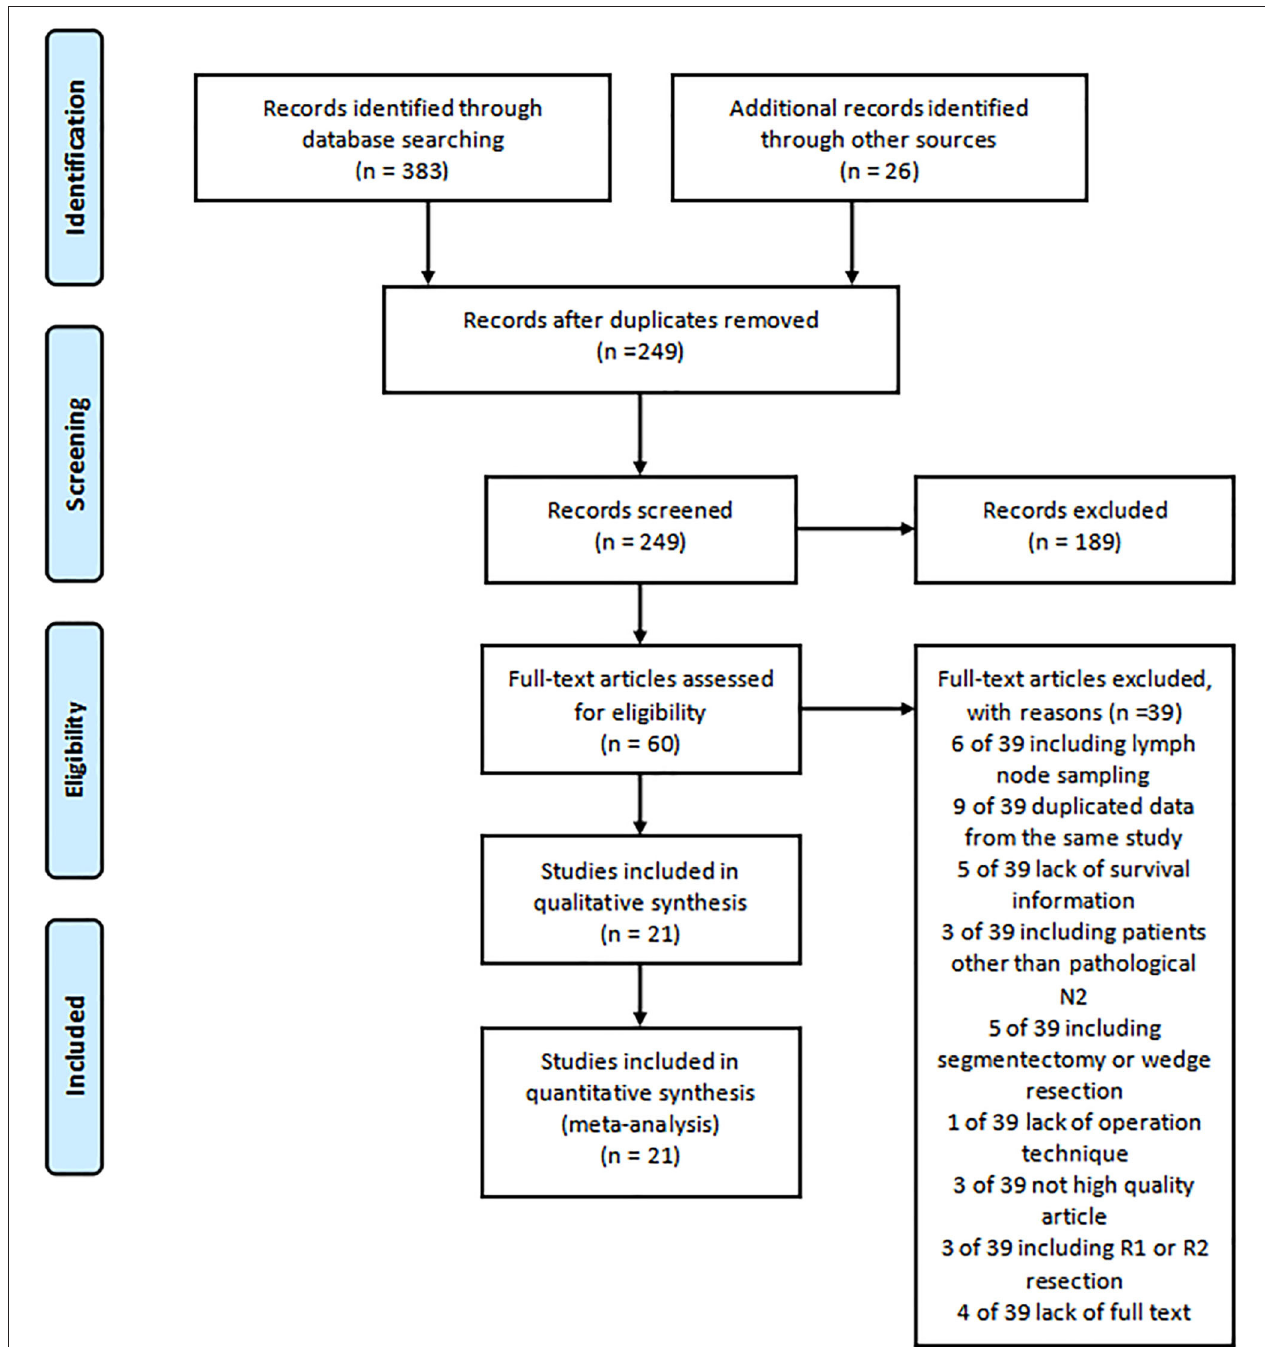
FIGURE 1 | Flowchart of studies selection.